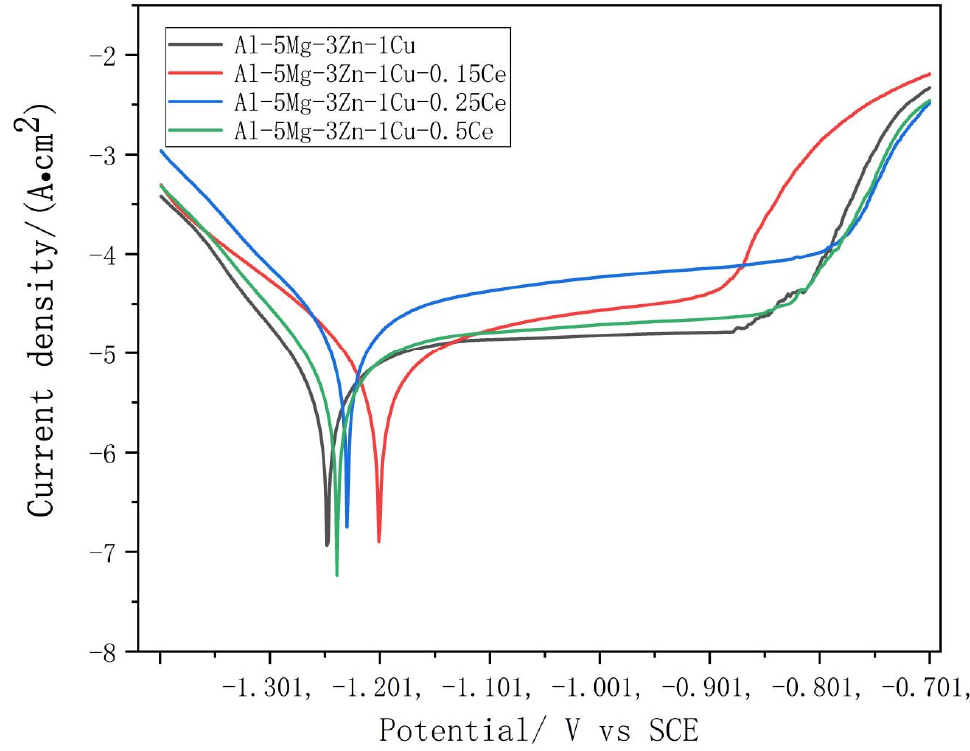
Figure 7. Potentiodynamic polarization curves of Al-5Mg-3Zn-1Cu alloys with different additive amounts of Ce. Table 4. The electrochemical parameters of Al-5Mg-3Zn-1Cu alloys with different Ce content.